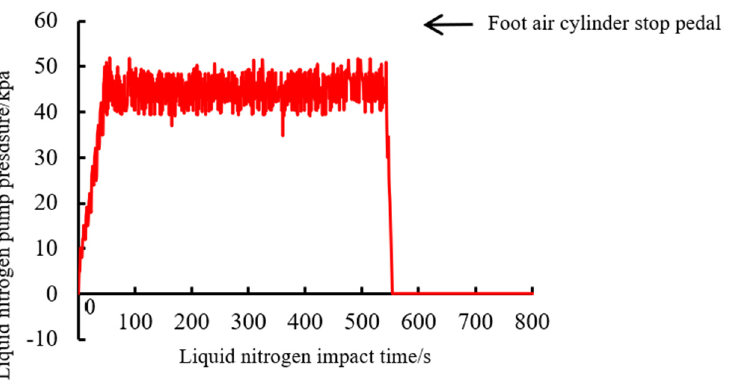
Figure 4. Pressure variation of the liquid nitrogen pump during the cryogenic thermal shock exper- iments.